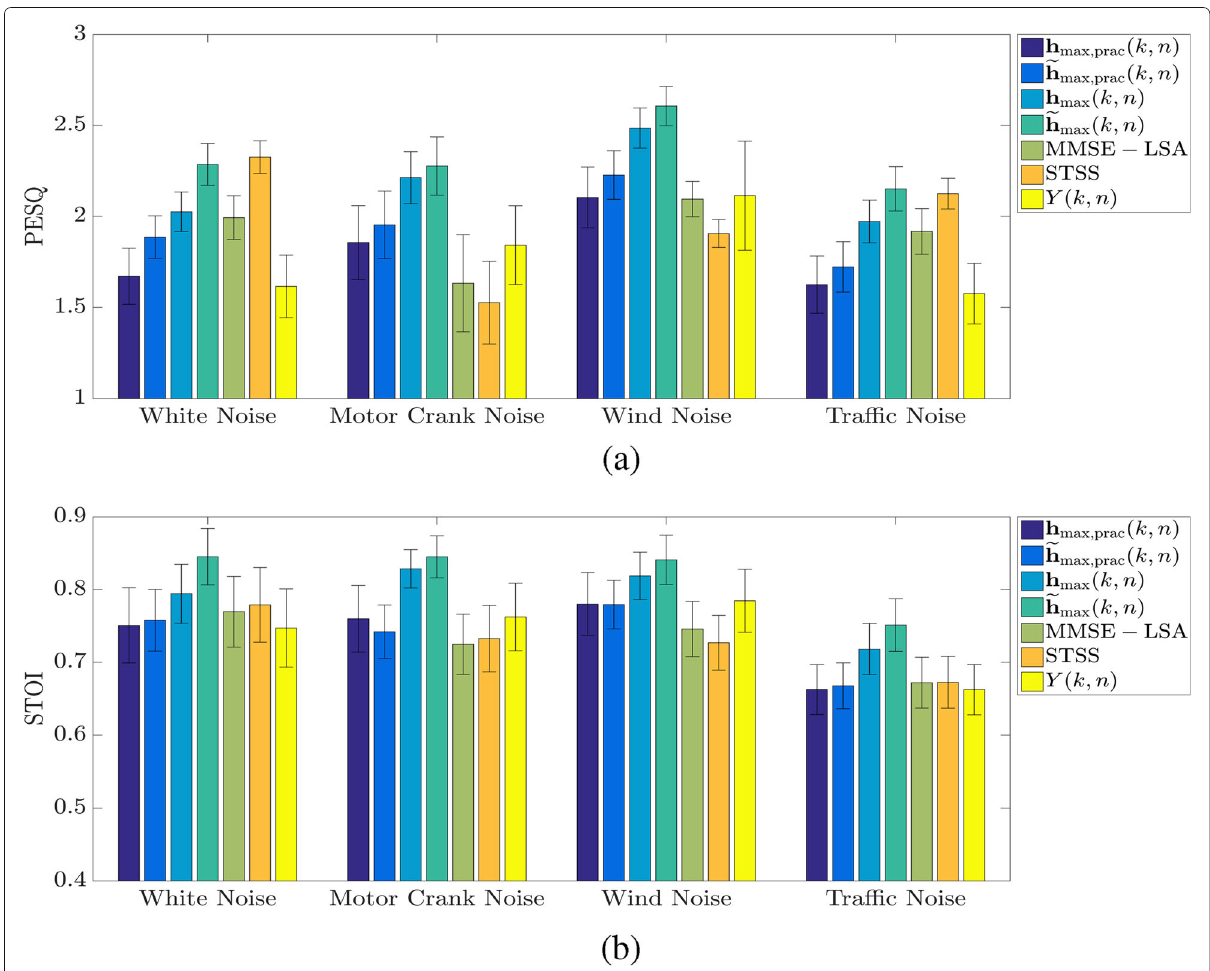
Fig. 5 A comparison of average PESQ and STOI scores of TIMIT speech signals in practical scenarios with iSNR = 0. The vertical margins exhibit the confidence (standard deviation) intervals computed over 24 speech utterances. h max,prac ( k , n ) and (cid:6) h max,prac ( k , n ) denote, respectively, the linear and quadratic maximum SNR filters in practical conditions; h max ( k , n ) and (cid:6) h max ( k , n ) denote, respectively, the linear and quadratic maximum SNR filters in ideal conditions; MMSE-LSA denotes the log-spectral amplitude estimator of [3]; STSS denotes the spectral subtraction in the short-time modulation domain method of [30]; Y ( k , n ) denotes the input noisy observation: a PESQ scores and b STOI scores. We set N = 3 for all four maximum SNR filters and τ y = 2 for the two quadratic maximum SNR